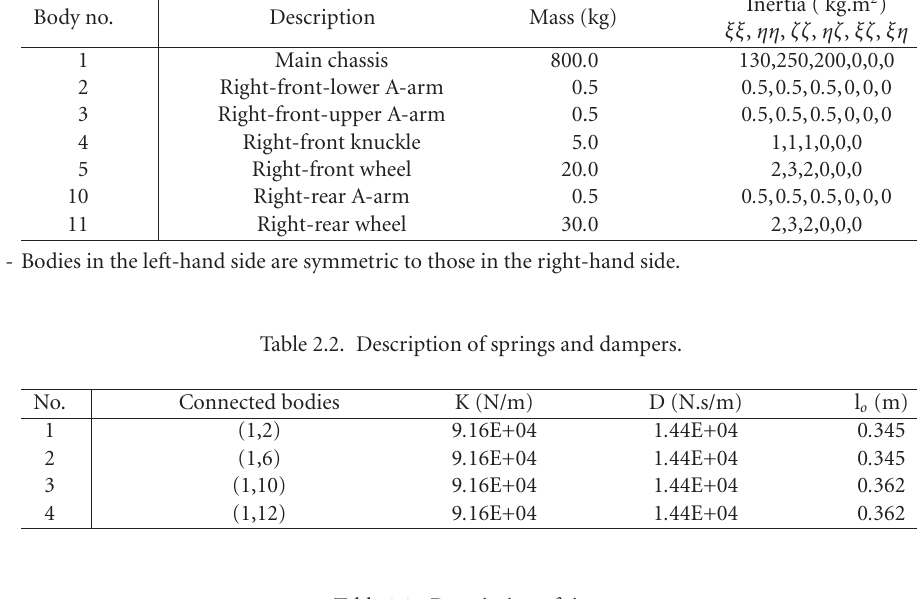
Table 2.3. Description of